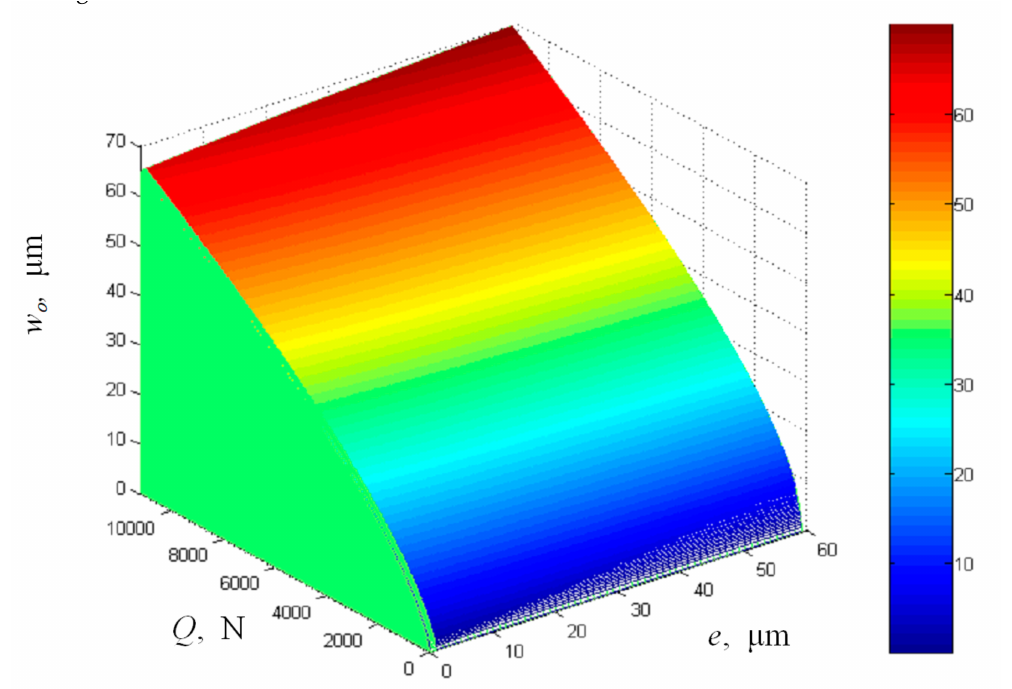
Figure 6. Three-dimensional dependence of bearing deflection ( w o ) on the size of internal radial clearance ( e ) and level of external load ( Q ), for the BSO position of 6206-single-row ball